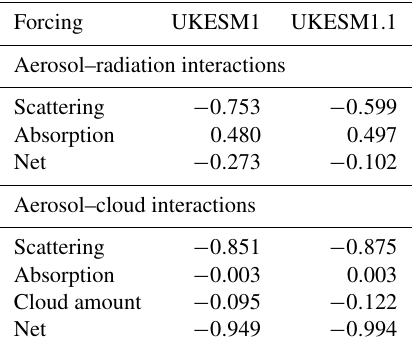
Table 4. The SW components of the aerosol effective radiative forc- ing (Wm − 2 ) in UKESM1.1 and